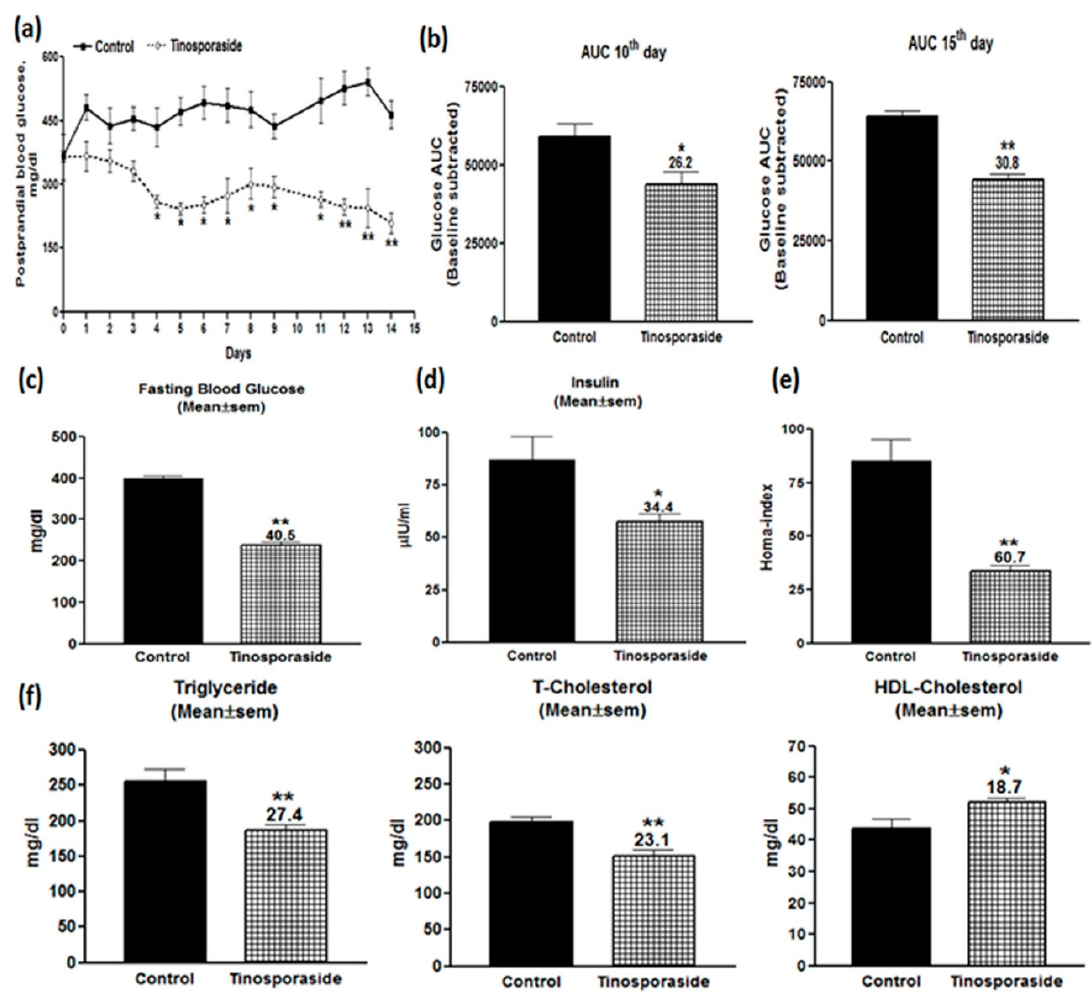
Figure 6. Antidiabetic effect of tinosporaside in C57BL-Ks db/db mice. Mice were treated daily with tinosporaside for15 consecutive days and blood glucose levels were monitored daily. Shown above are effects on postprandial blood glucose levels ( a ), OGTT at day 10 and day 15 ( b ), fasting blood glucose ( c ), serum insulin level ( d ), HOMA-index ( e ), and serum lipid profile ( f ). Data are expressed as the mean ± SE value, n = 5. * p < 0.05, ** p < 0.01, relative to control animals.